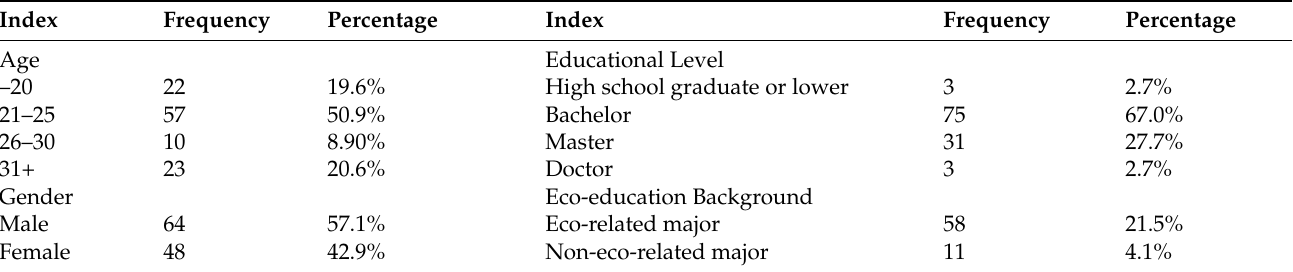
Table 1. Demographic information of the sample in this